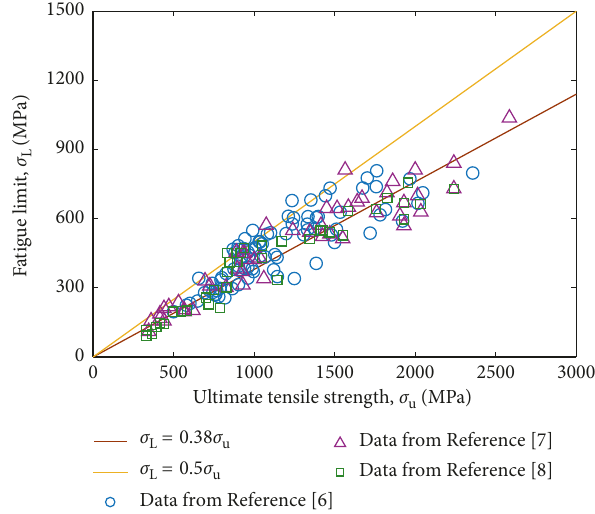
Figure 1: Fatigue limit vs. ultimate tensile